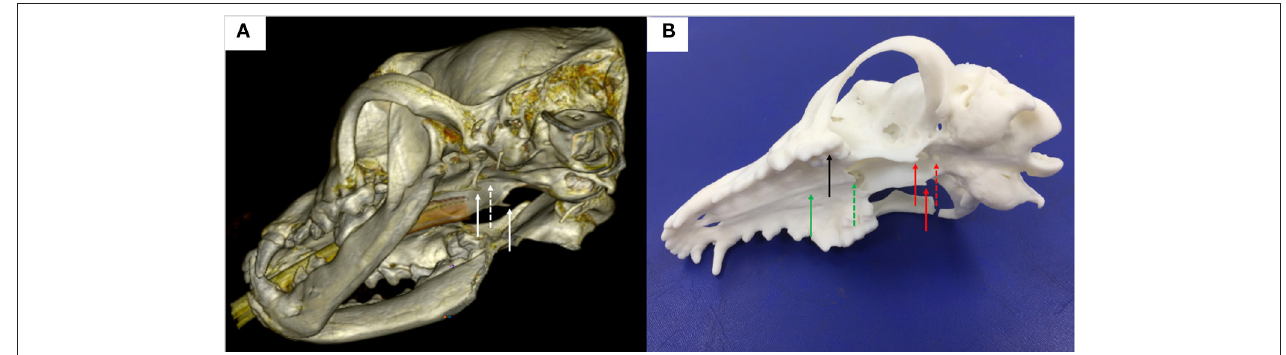
FIGURE 1 | (A) 3-dimensional reconstruction of a canine head in a bone window using DICOM images generated from CT and the medical imaging software Horos; note the hamuli processes, part of the pterygoid bone (plain white arrows) and the basisphenoid bone where a window needs to be burred (dashed white arrow) in the midline between the hamuli processes; (B) 3-dimension printed skull from the DICOM images; note again the hamuli processes (plain red arrows) and the basisphenoid bone where a window has been burred (dashed red arrow) in the midline between the hamuli processes; other anatomical landmarks used for the surgical guide design were the upper teeth (black plain arrow), the hard palate (green plain arrow) and the vomer (green dashed arrow).